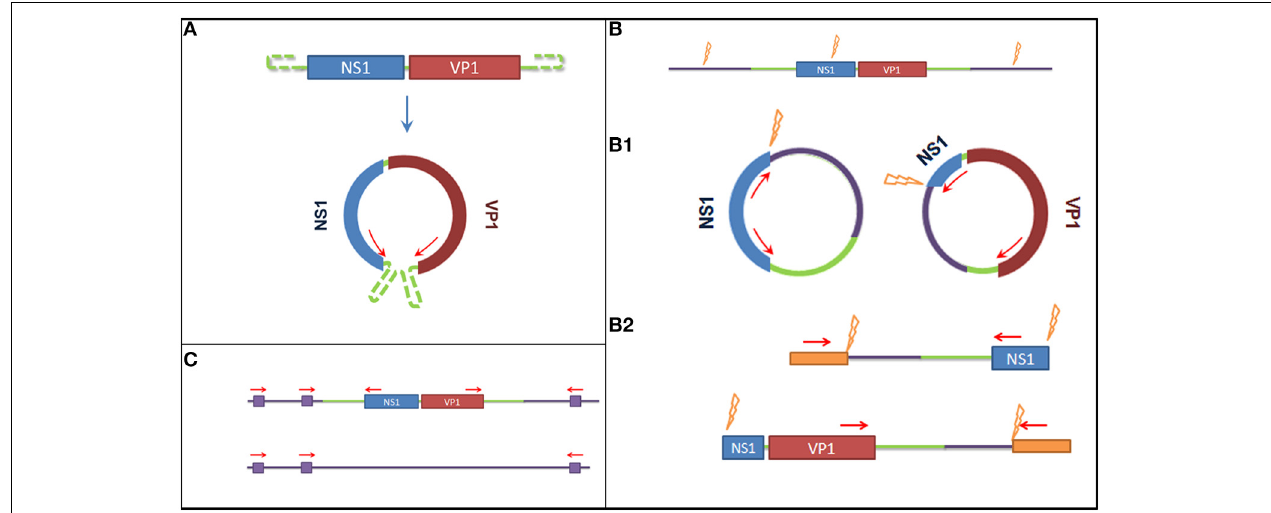
FIGURE 1 | Graphical overview of the methods used to detect latent viral forms. (A) Method used to detect episomal genomic DNA. On the top the genome organization of the Sl.L-PV-1, on the bottom a representation of the predicted circular form. Red arrows represent primer binding sites. The use of reverse primer annealing at the beginning of NS1 and forward primers annealing at the end of VP1 allows the amplification the connecting genomic sequence. (B) Restriction enzyme based methods to detect integrated virus. The purple lines represent the host genomic sequence, the orange flashes indicate restriction enzyme sites and the orange boxed indicate artificially ligated adaptors. (B1) It is shown how, after overnight ligation of the digested DNA, the obtained fragment would